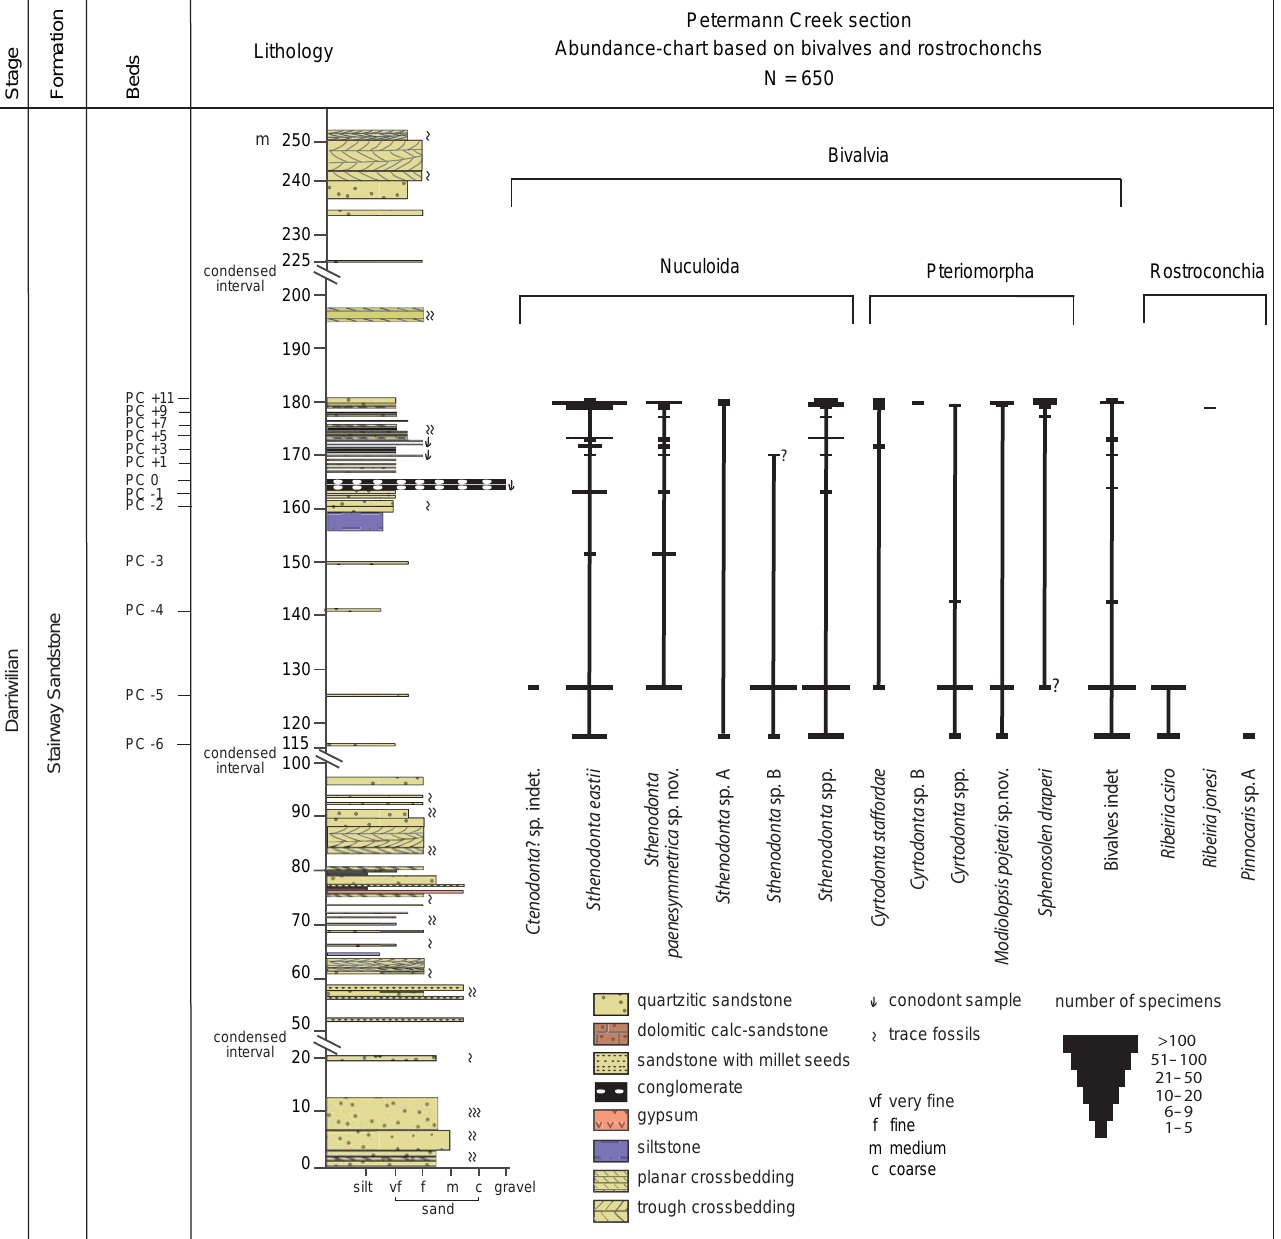
Fig. 5. Composite log of the Stairway Sandstone and abundance-charts showing distribution of bivalves and rostroconchs in the Petermann Creek